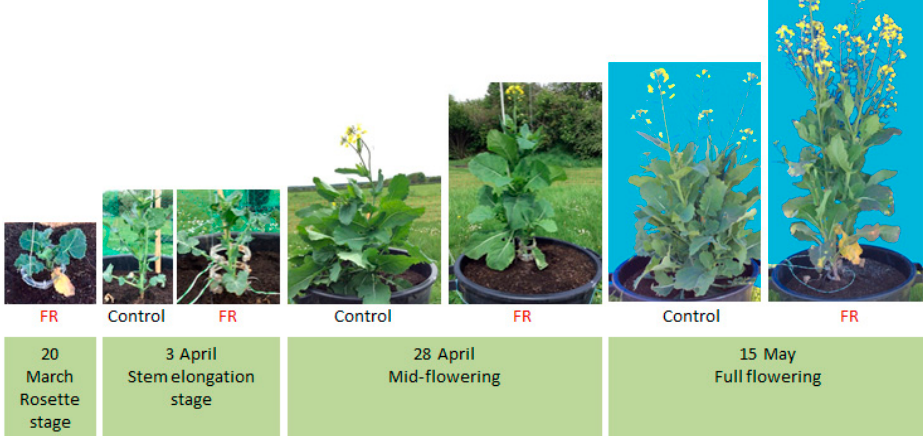
Figure 4. Development of Control- and FR-treated plants from the rosette stage (20 March 2014) to their full flowering stage (15 May 2014). The LightCue transmitters were added from 18 March to 1 April, ring by ring, up to three, as the stem grew.